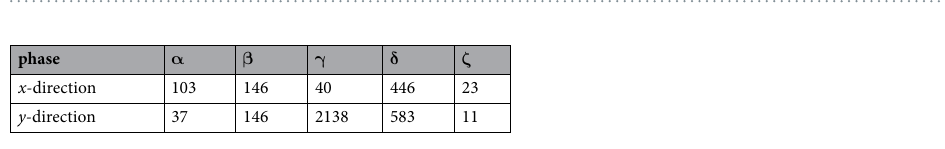
Figure 8. Total scattering phase space for: ( a ) α -phosphorene, ( b ) β -phosphorene, ( c ) γ -phosphorene, ( d ) δ -phosphorene, and ( e ) ζ -phosphorene in three-phonon scattering